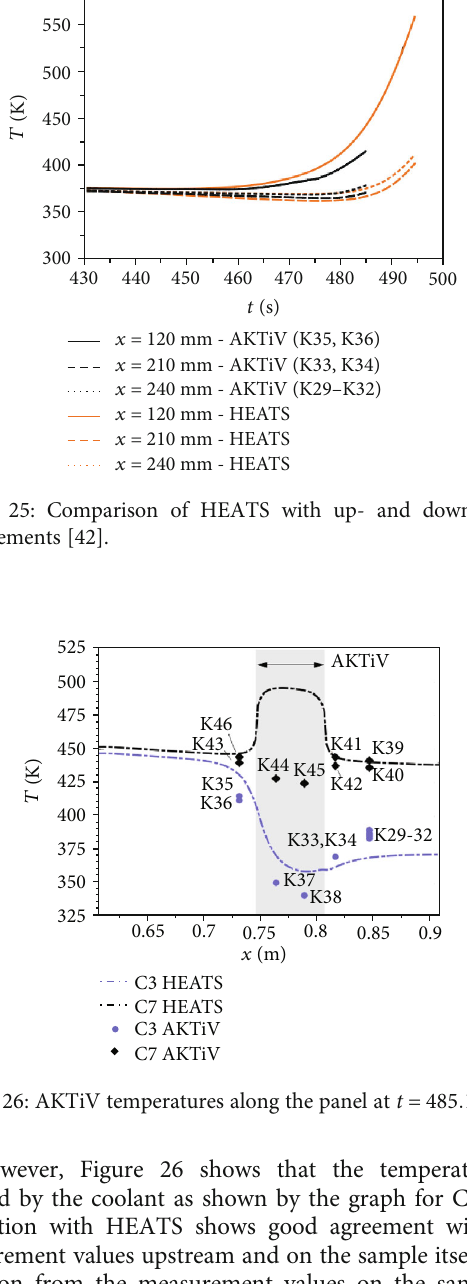
Figure 26: AKTiV temperatures along the panel at t = 485 : 12